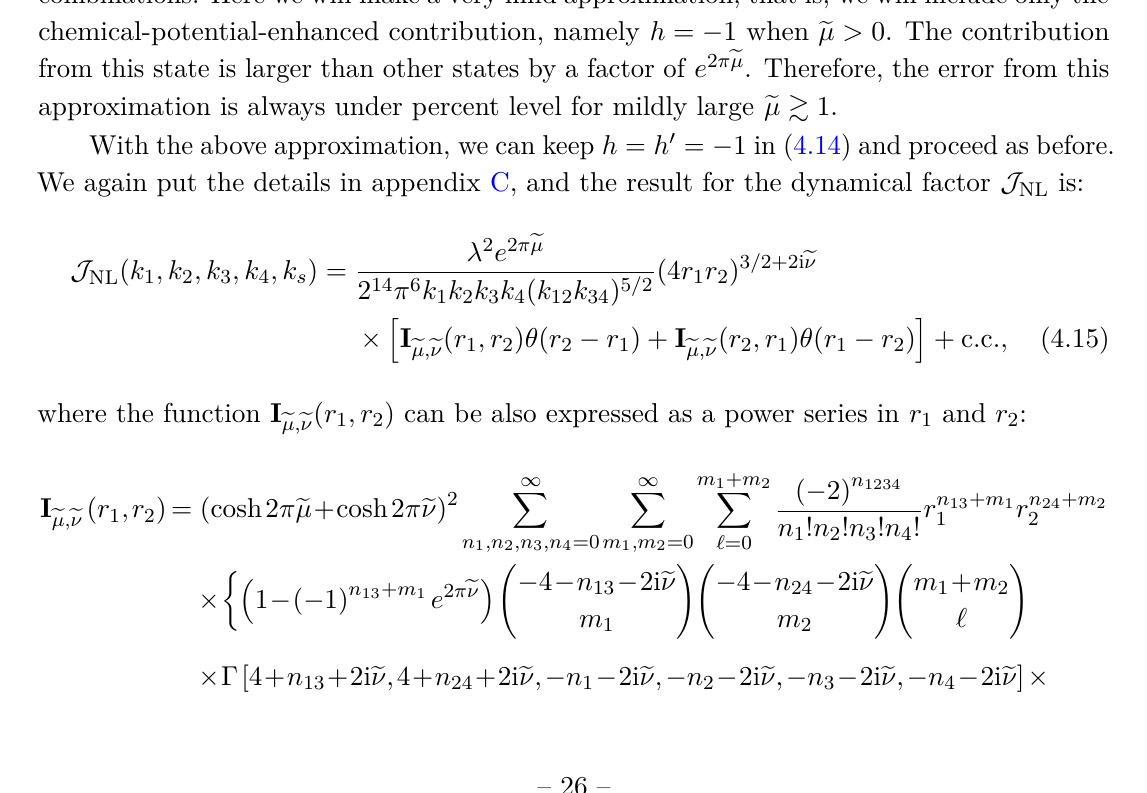
µ = µ/H , for time-derivative e